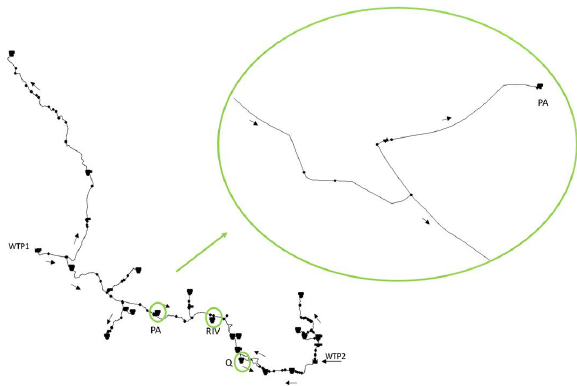
Figure 1. Water transmission system layout, identification of the three identified sites for energy recovery and detail of the location with highest potential.